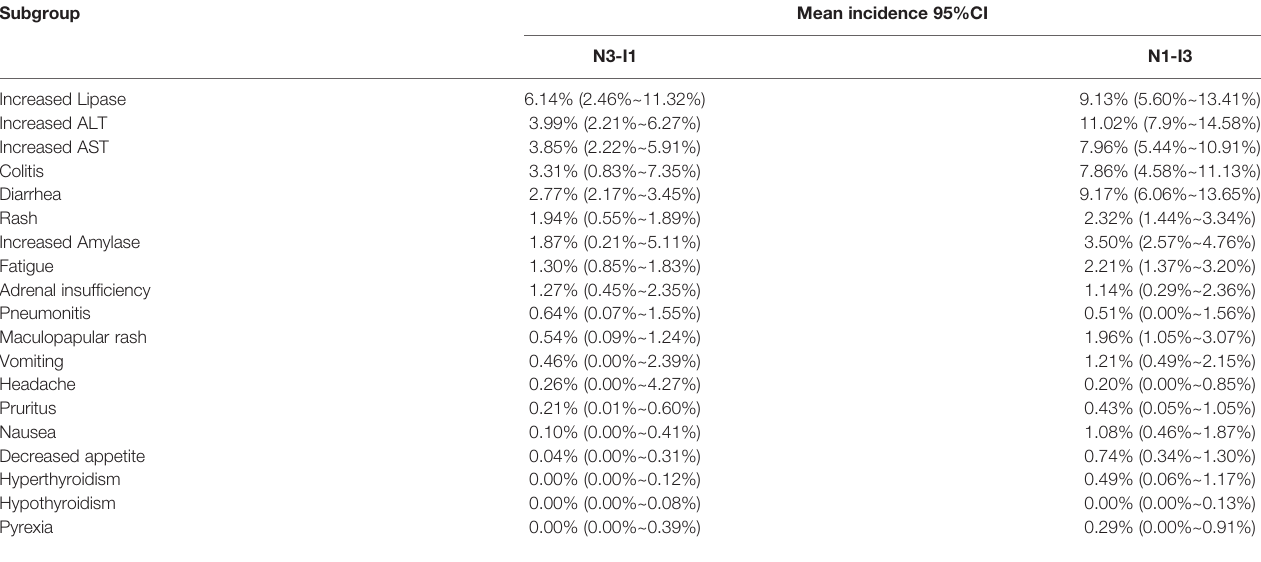
TABLE 3 | Risk ratio of grade 3 and higher adverse events for N3-I1 and N1-I3 subgroup. Subgroup